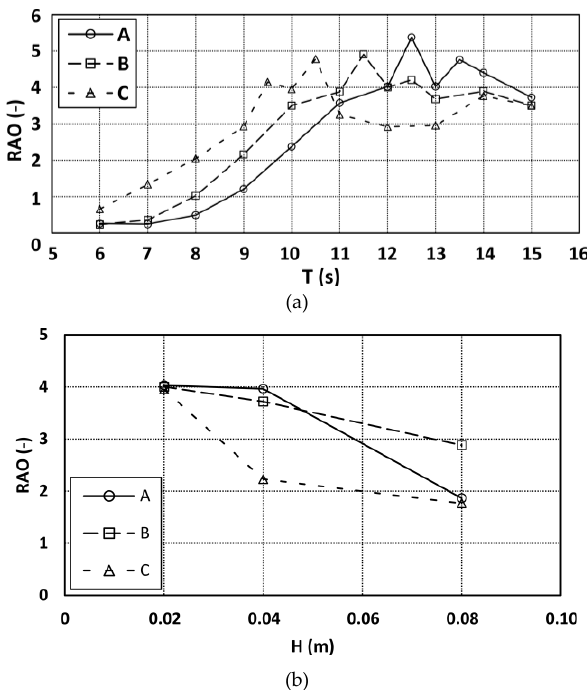
Fig. 6. Response Amplitude Operator for geometries A, B and C for (a) a fixed wave height of 0.02 m and (b) a fixed wave period, equal to each geometry’s resonant period. Wave period values are in full -scale.